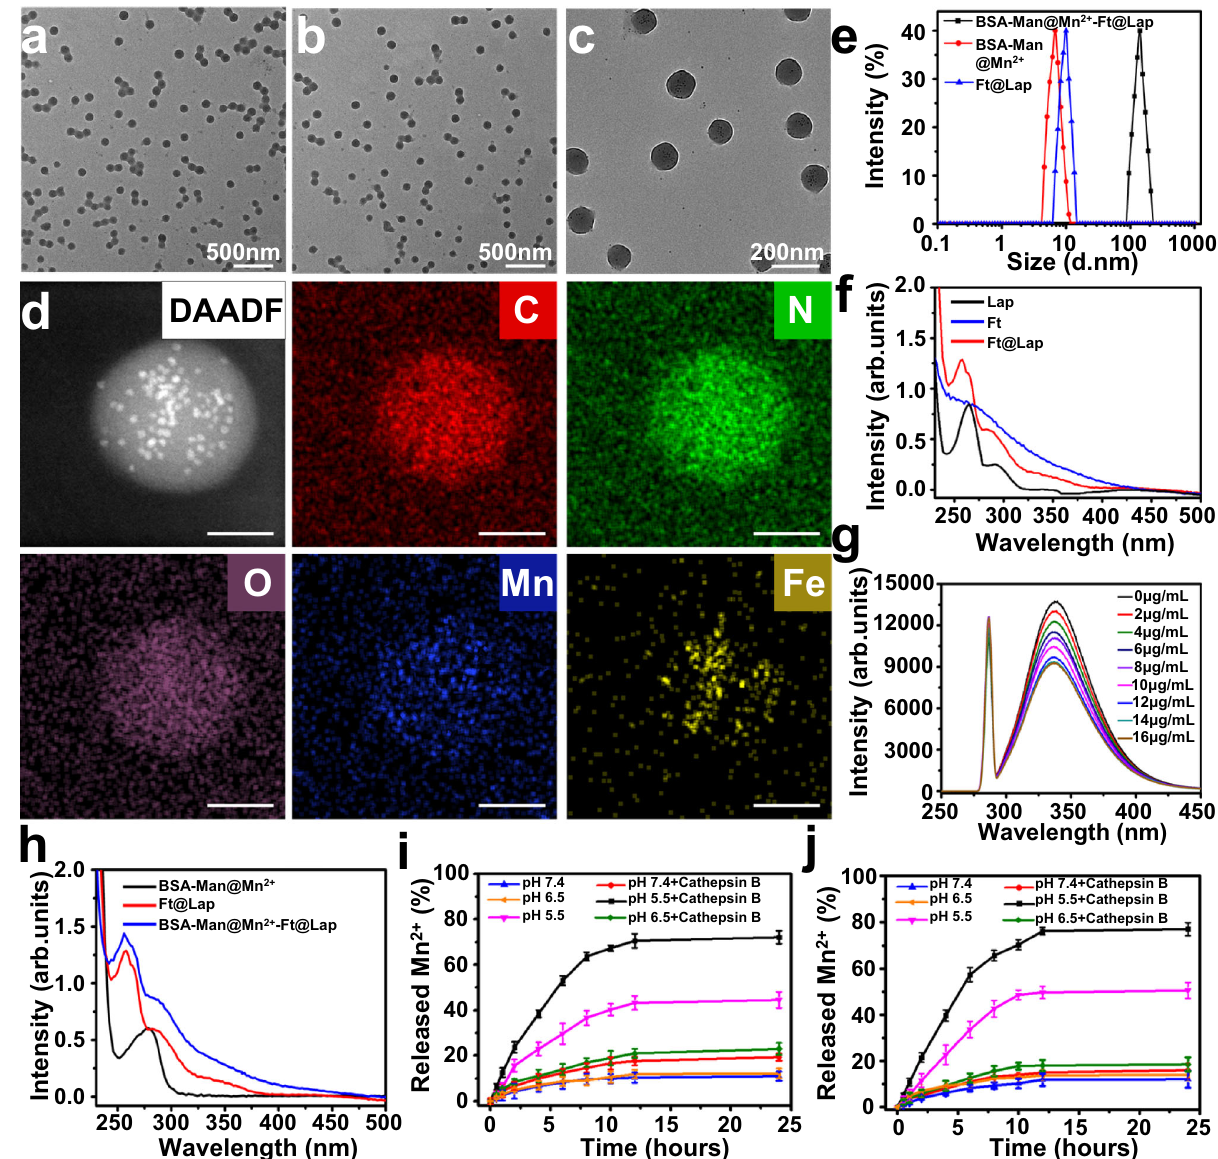
Fig. 2 | Physical characterization of the BSA-Man@Mn 2+ -Ft@Lap nanoassem-